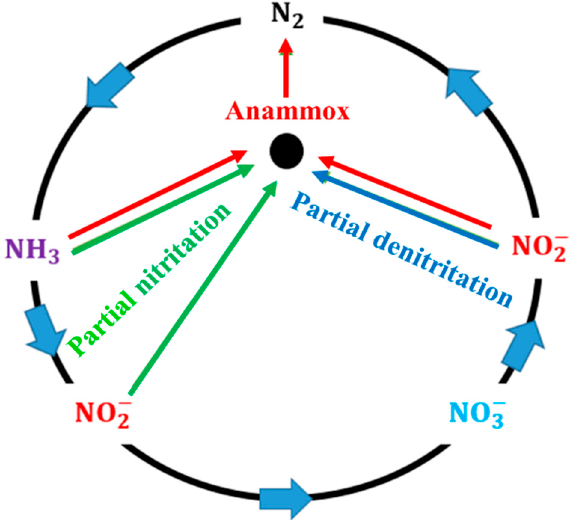
Figure 1. The schematic pathway of nitrogen transformation with implementation of technologies based on anammox process.